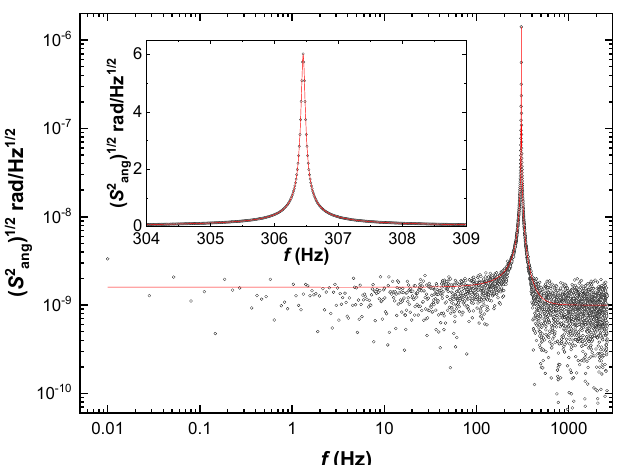
Figure 2. Free-standing frequency response of the oscillator with the Au-coated sphere glued to it. The high frequency response shows the limits of the detection circuit. The inset shows an expanded view of the resonance with an average of 100 different spectra. The red solid line is a fit using (2) with a detection flat spectral density noise of 1.2 10 − 9 rad/ √ Hz. Points below 0.025 Hz where × 1/ f -noise is measurable have been excluded from the